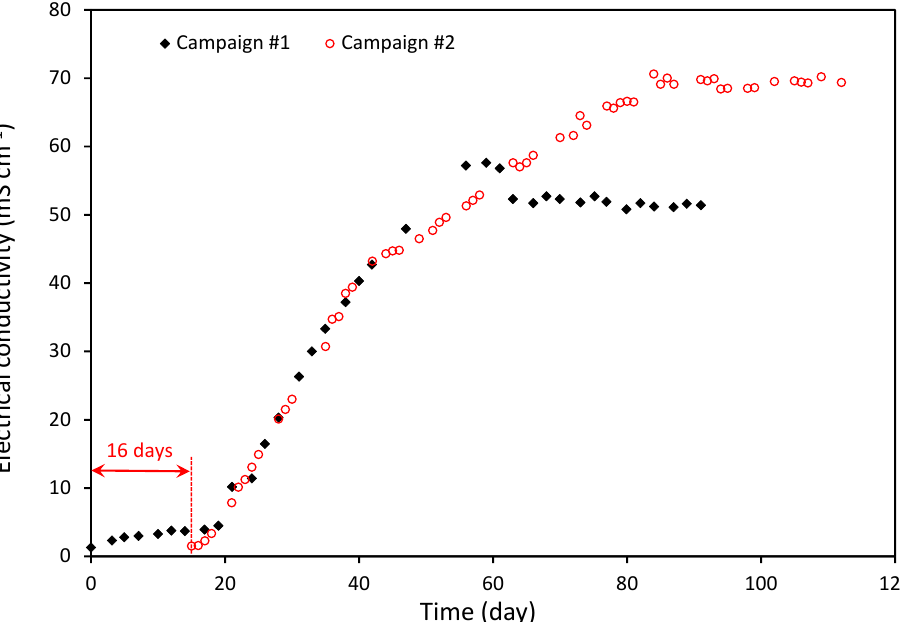
Figure 4. Comparison between EC changes recorded for campaigns #1 and #2. A shift of 16 days was applied to the results for campaign #2 to match the two curves accurately and to take the biomass acclimation period recorded in campaign #1 into account. Table 2. Main results calculated for campaigns #1 and #2.